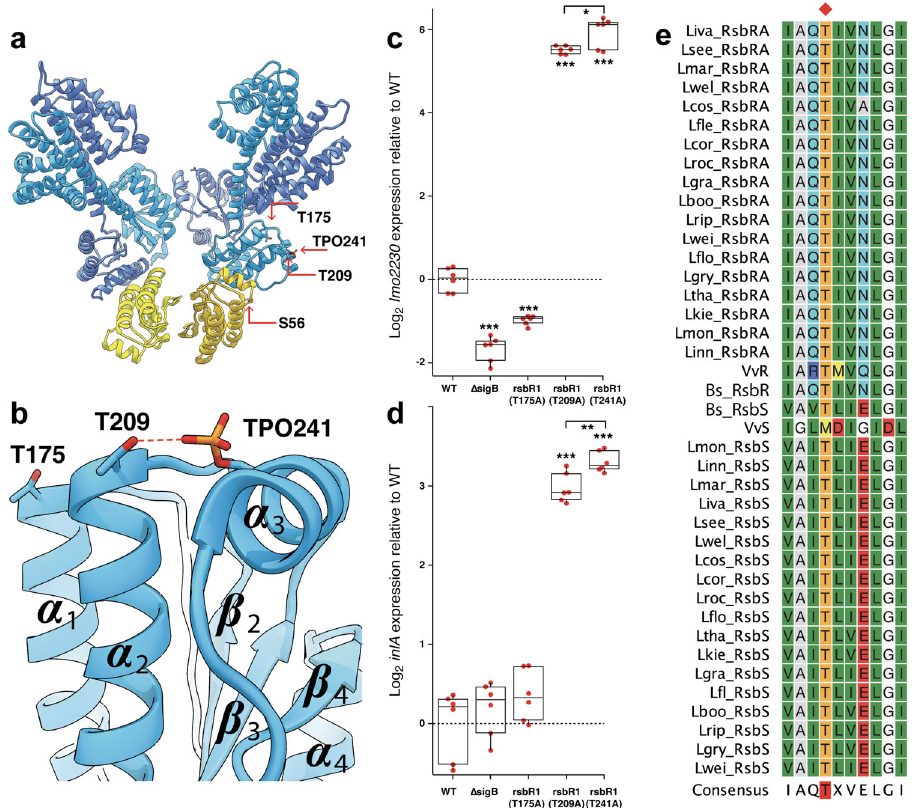
Fig. 3 Phosphorylation sites and their surroundings in Li RsbRS. a The heterotriangle formed from two dimers of RsbR and one dimer of RsbS, with the regulatory phosphorylation sites and their interaction partners indicated by red arrows. b a close-up of the RsbS interaction surface, with Ser56 shown in ɑ 2 and the Thr88 in ɑ 3 . c Relative expression of the SigB-dependent genes lmo2230 ( c ) and inlA ( d ) in unstressed L. monocytogenes cells relative to wild type in mutants of rsbR1 and sigB . The mean value is shown by the horizontal line in the boxes, and the height of the box indicates standard deviation, n = 6 for each experiment. e Alignment of STAS domain proteins found in different Gram-positive bacteria, with the conserved T241 residue indicated with a red diamond. The raw data for panels c and d can be found in Supplementary Data